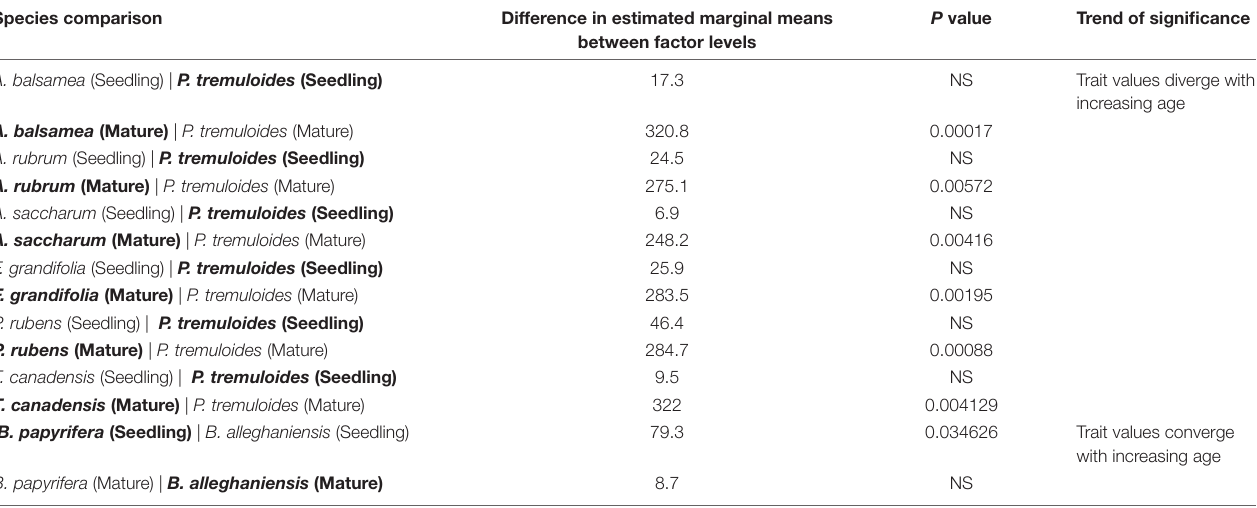
TABLE 3 | Subset of post hoc pairwise comparisons of the LDMC estimated marginal means across life stage for the selected best-fit model, where trait values significantly diverge with age 1 . Species comparison Difference in estimated marginal means between factor